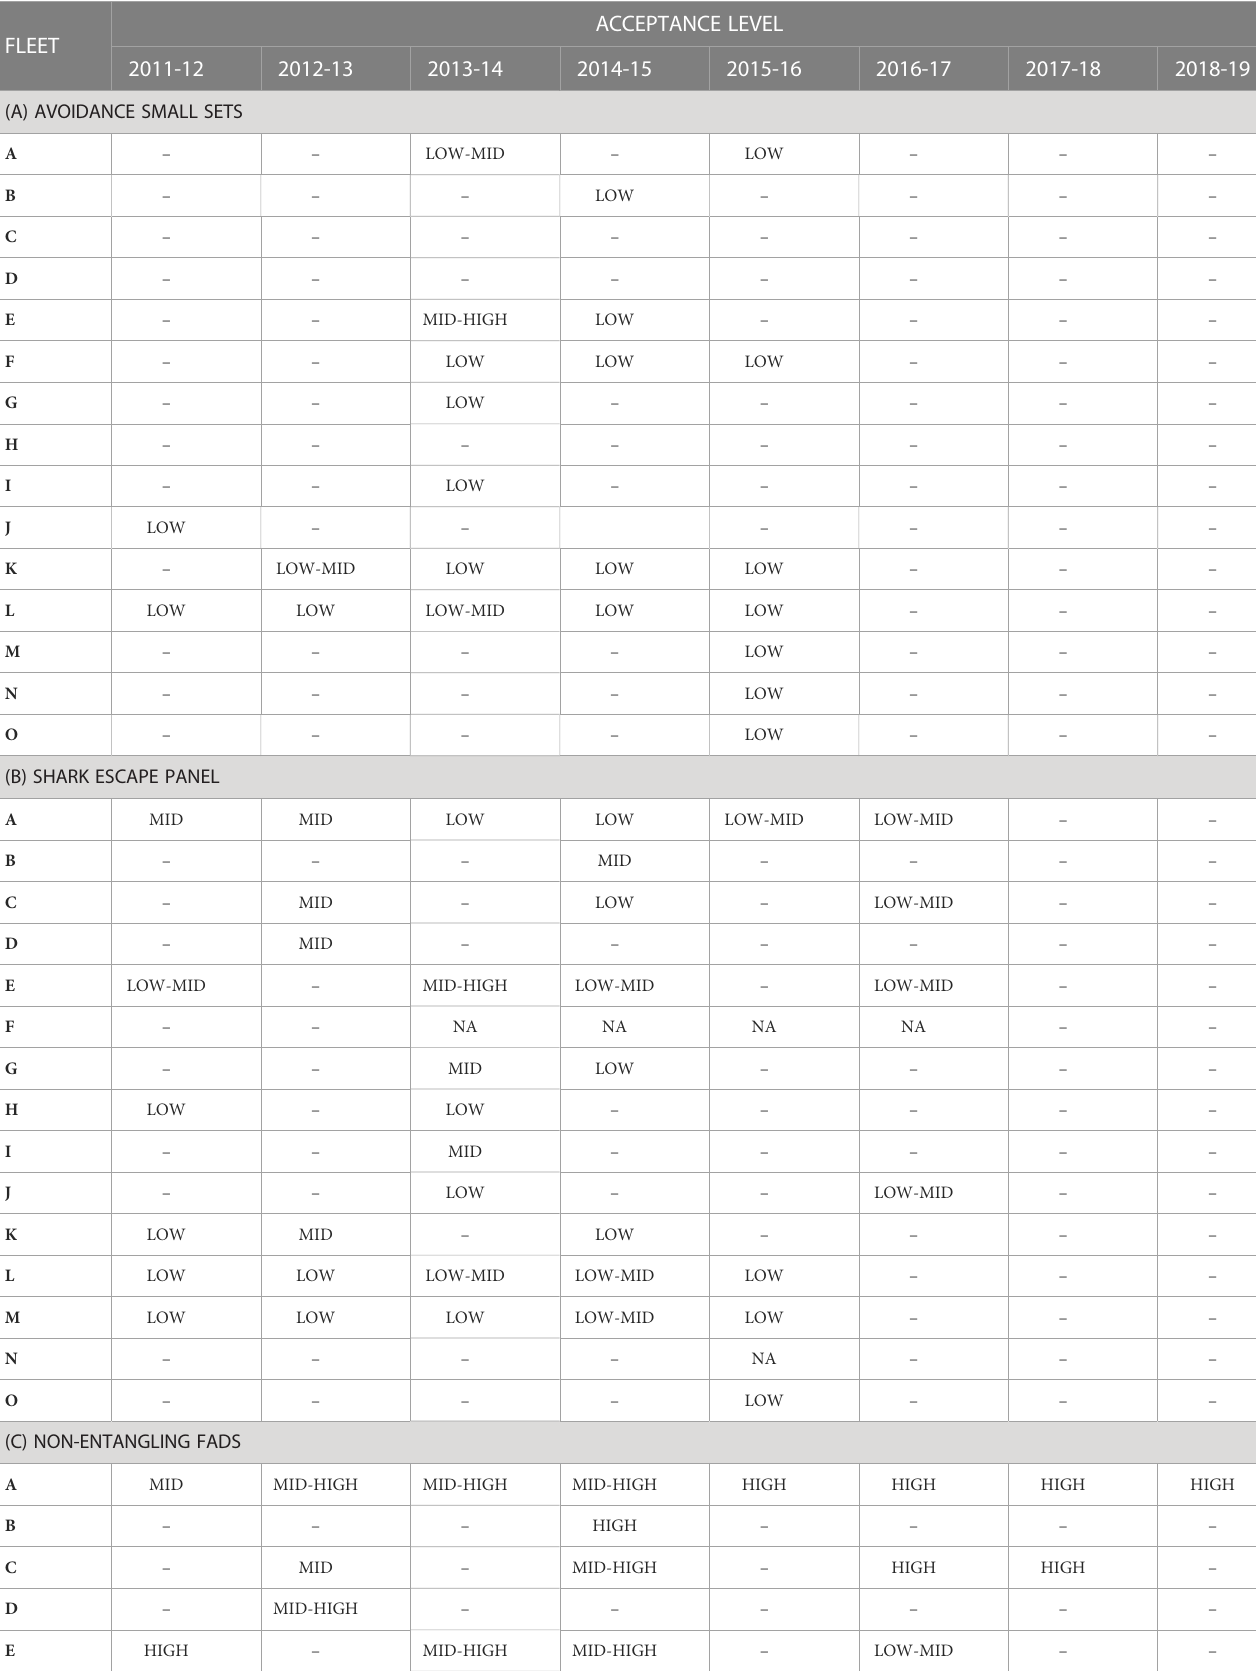
TABLE 3 Evolution of ISSF Skippers Workshop impact mitigation activity acceptance by fi shers for (A) avoidance of small FAD sets, (B) shark escape panel, (C) non-entangling FADs, (D) biodegradable FADs, (E) best bycatch release practices from deck, and (F) echo-sounder buoy